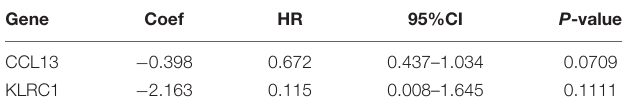
TABLE 1 | Multivariate Cox analyses based on 2 hub